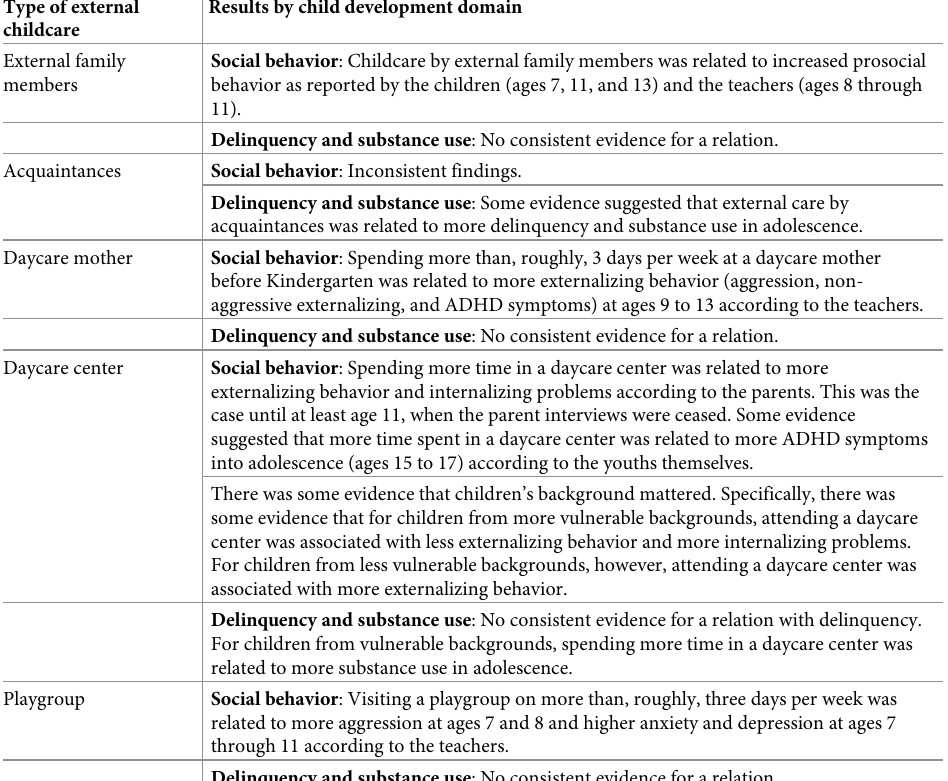
Table 6. Overview of main findings on the relation between external childcare and socio-behavioral development by type of care. Type of external